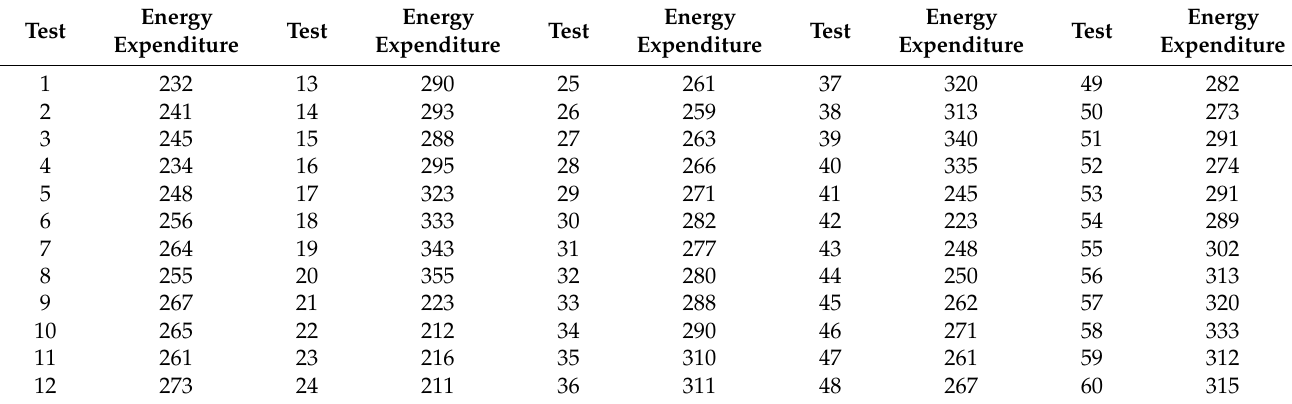
Table 9. Summary of the results of the ant colony algorithm